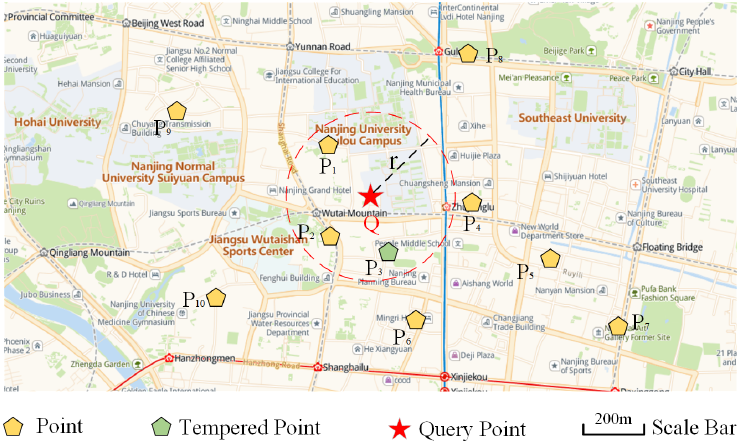
Figure 1. The scenario of spatio-temporal k nearest neighbors query [44]. Given a set of check-ins of spatio-temporal points, kNN ( k = 3) finds the nearest points of query point Q . The r denotes the minimum extension radius of query range that contains exactly k results. If we consider spatial closeness only, we will obtain three points for Q , i.e., P 1 , P 2 , and P 3 . However, if we consider temporal concurrency as well, P 3 may no longer be the k nearest to Q when it is